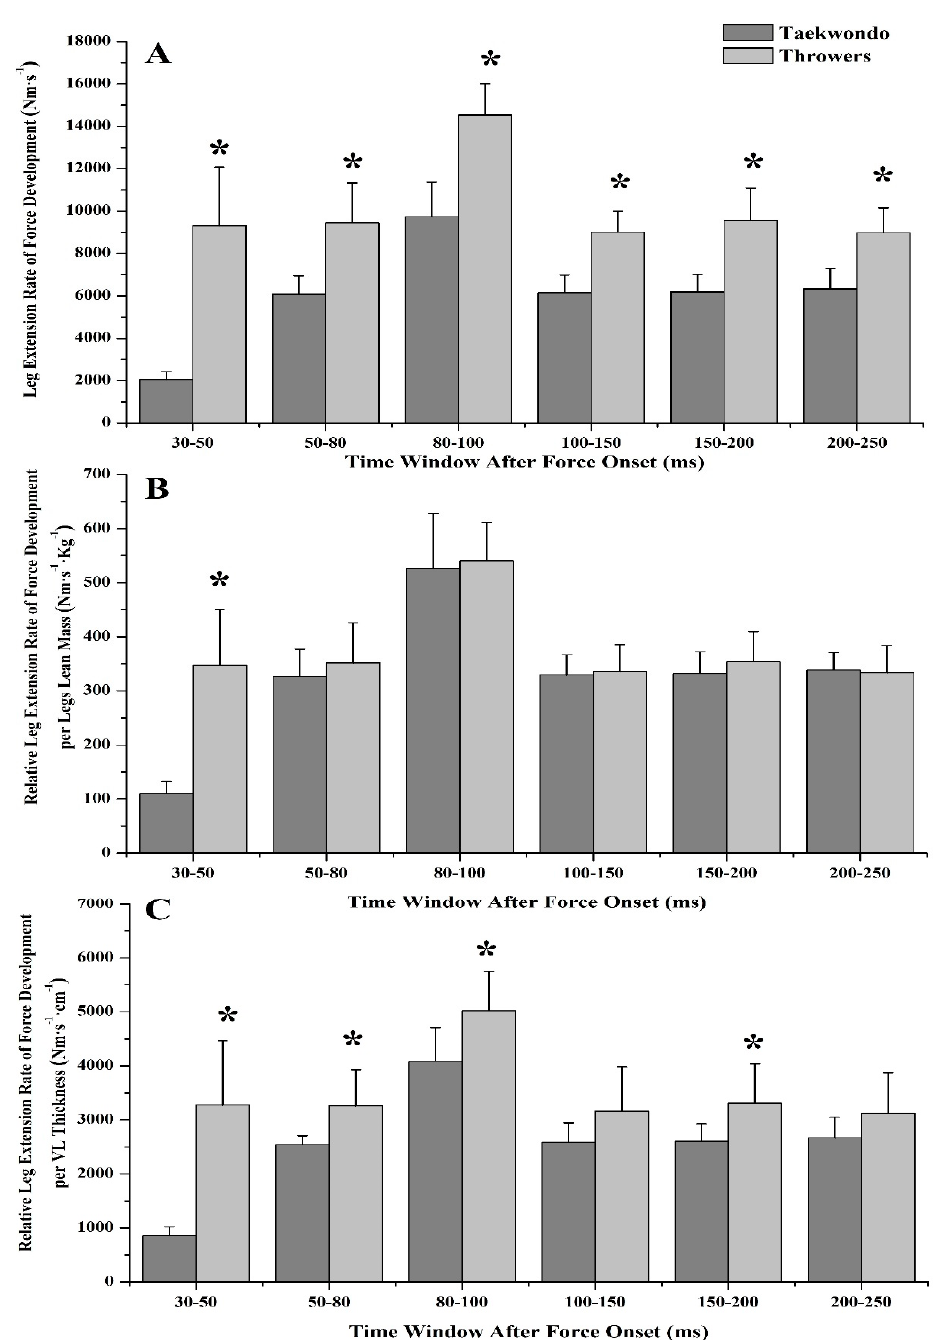
Figure 4. Leg extension sequential rate of force development (SRFD) for taekwondo athletes (dark grey) and track and field throwers (light grey). ( A ) Leg extension SRFD in absolute values. Track and field throwers had greater SRFD than taekwondo athletes in all time windows. ( B ) Leg extension SRFD relative to lower body lean mass. Significant difference was found between during 30–50 ms for the taekwondo athletes compared to throwers. ( C ) Leg extension SRFD relative to VL muscle thickness. Significant difference was found during 30–50, 50–80, 80–100, and 150–200 ms for throwers in comparison to taekwondo (* p < 0.05).